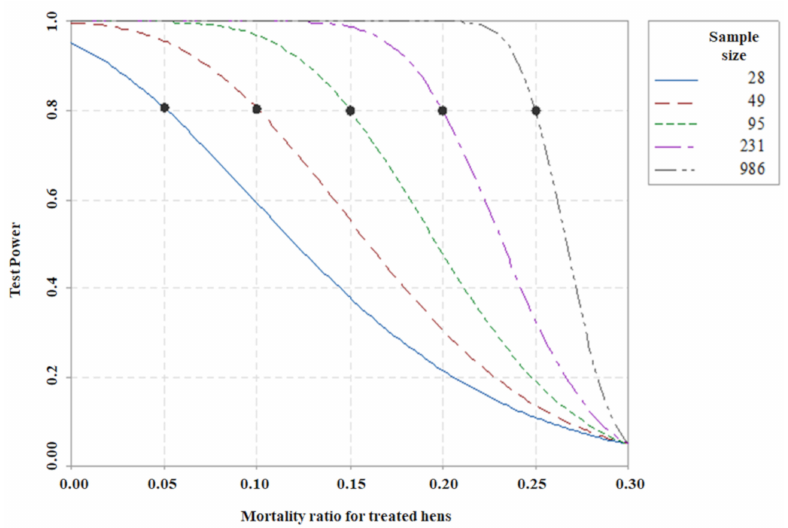
Figure 5. Calculation of the theoretical sample size to demonstrate the test power obtained in this